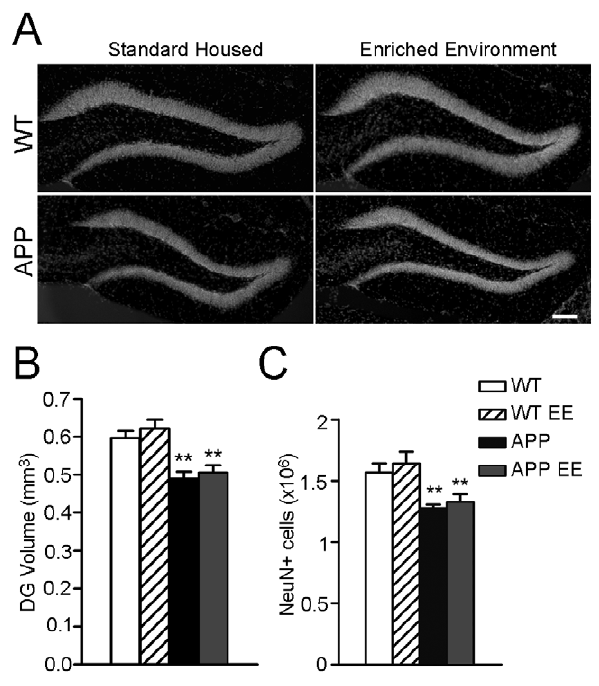
Figure 6. APP Sw,Ind mice show reduced neurons in the dentate gyrus. (A) Representative epiflurescence microscopy images of the granule cell layer (GCL) of the dentate gyrus counterstained with Hoechst. Reduced thickness of the GCL is evident in standard housed and enriched APP Sw,Ind mice. Scale bar =100 m m. (B) Quantitative analysis show a significant reduction of GCL volume in APP Sw,Ind mice. (C) Total number of neurons stained for NeuN in the GCL of standard housed and enriched (EE) APP Sw,Ind mice was significantly reduced compared with WT mice. Data represent mean 6 SEM. *p , 0.05; **p , 0.01, compared to WT mice. Number of mice: WT (n=8), enriched WT (n=7), APP Sw,Ind (n=6) and enriched APP Sw,Ind (n=6).